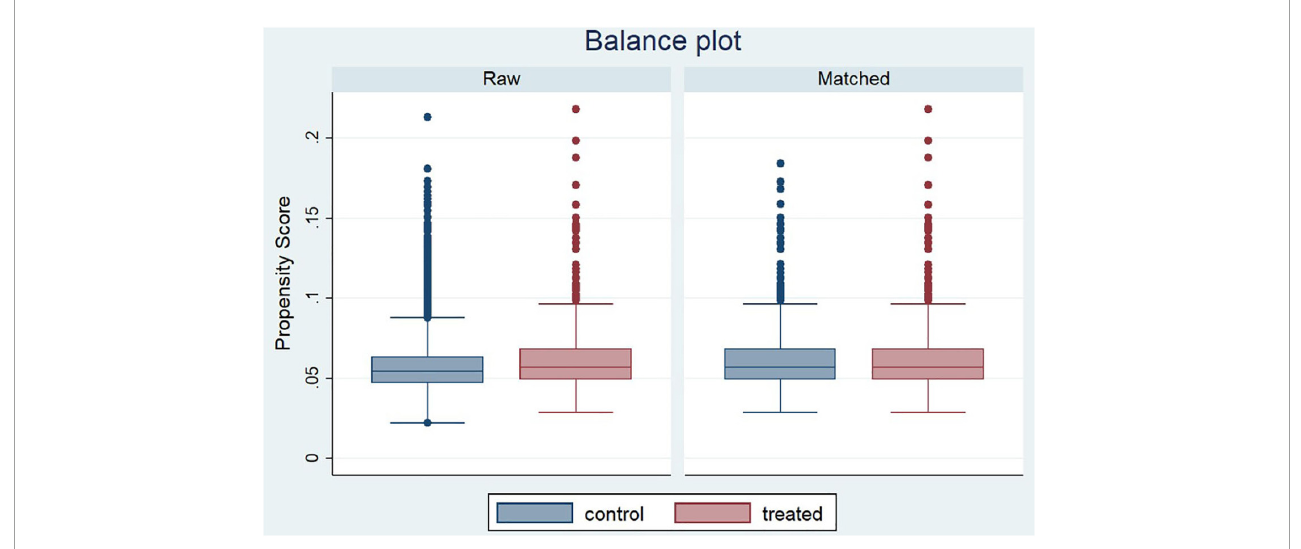
FIGURE1 Box plot of covariates before and after